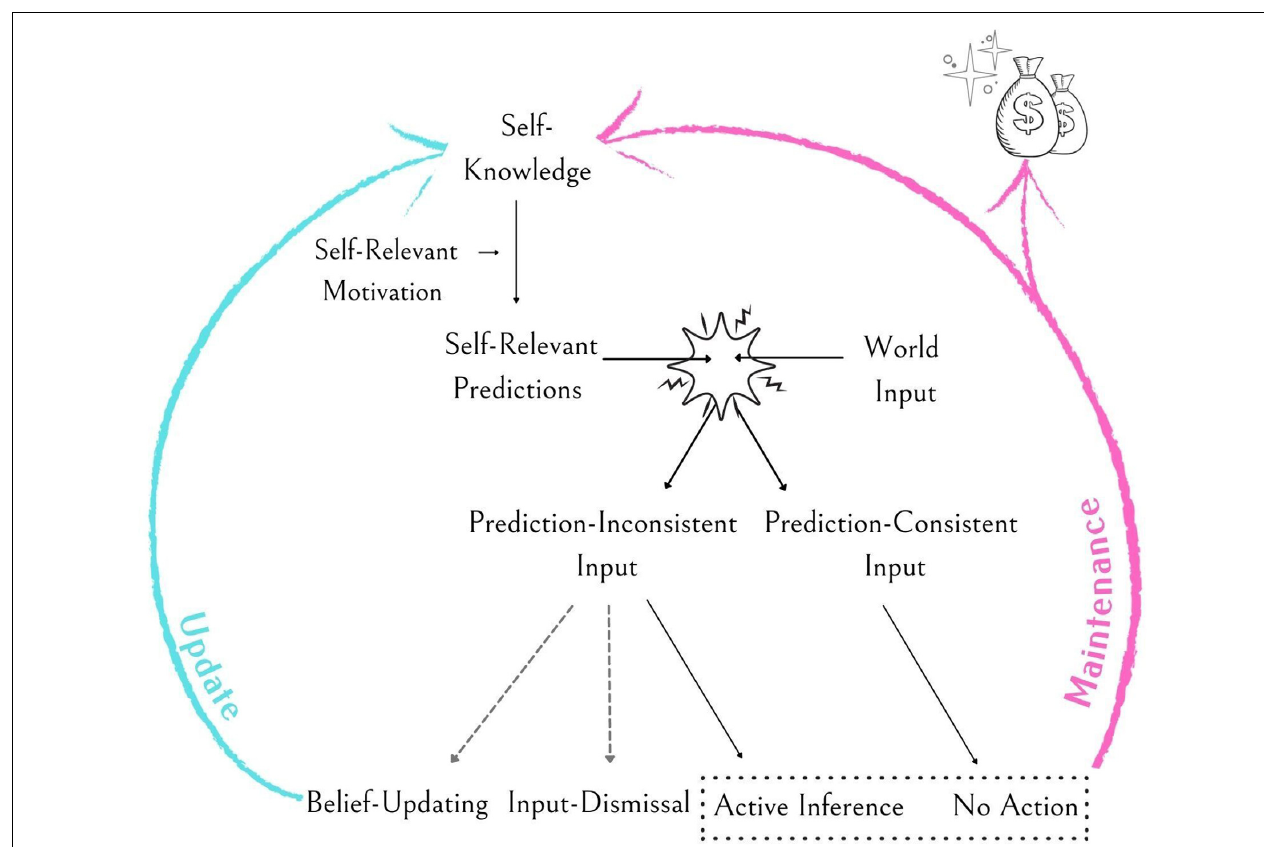
FIGURE 1 | Illustration of the proposed model. Self-Knowledge serves as an inner model of the self (i.e., prior) from which predictions are derived. The (context-dependent) dominant self-relevant motivation, be it self-verification, self-enhancement, or another form of motivation, mediates these predictions. These predictions are compared with inputs from the world, leading to a match or a mismatch. The outcomes of these comparisons lead to one of several possible outcomes. The less likely outcomes (indicated by broken lines in the figure) include model updating (in the unlikely case of belief-updating following prediction-inconsistent information) and input-dismissal (when receiving information that seems extremely irrelevant to the self). More likely outcomes (indicated by solid lines) include self-knowledge maintenance via active inference or prediction-consistent input. The more likely outcomes (grouped by the broken lined box) also generate a reward response (money bag), thus further increasing their likelihood to be used in the